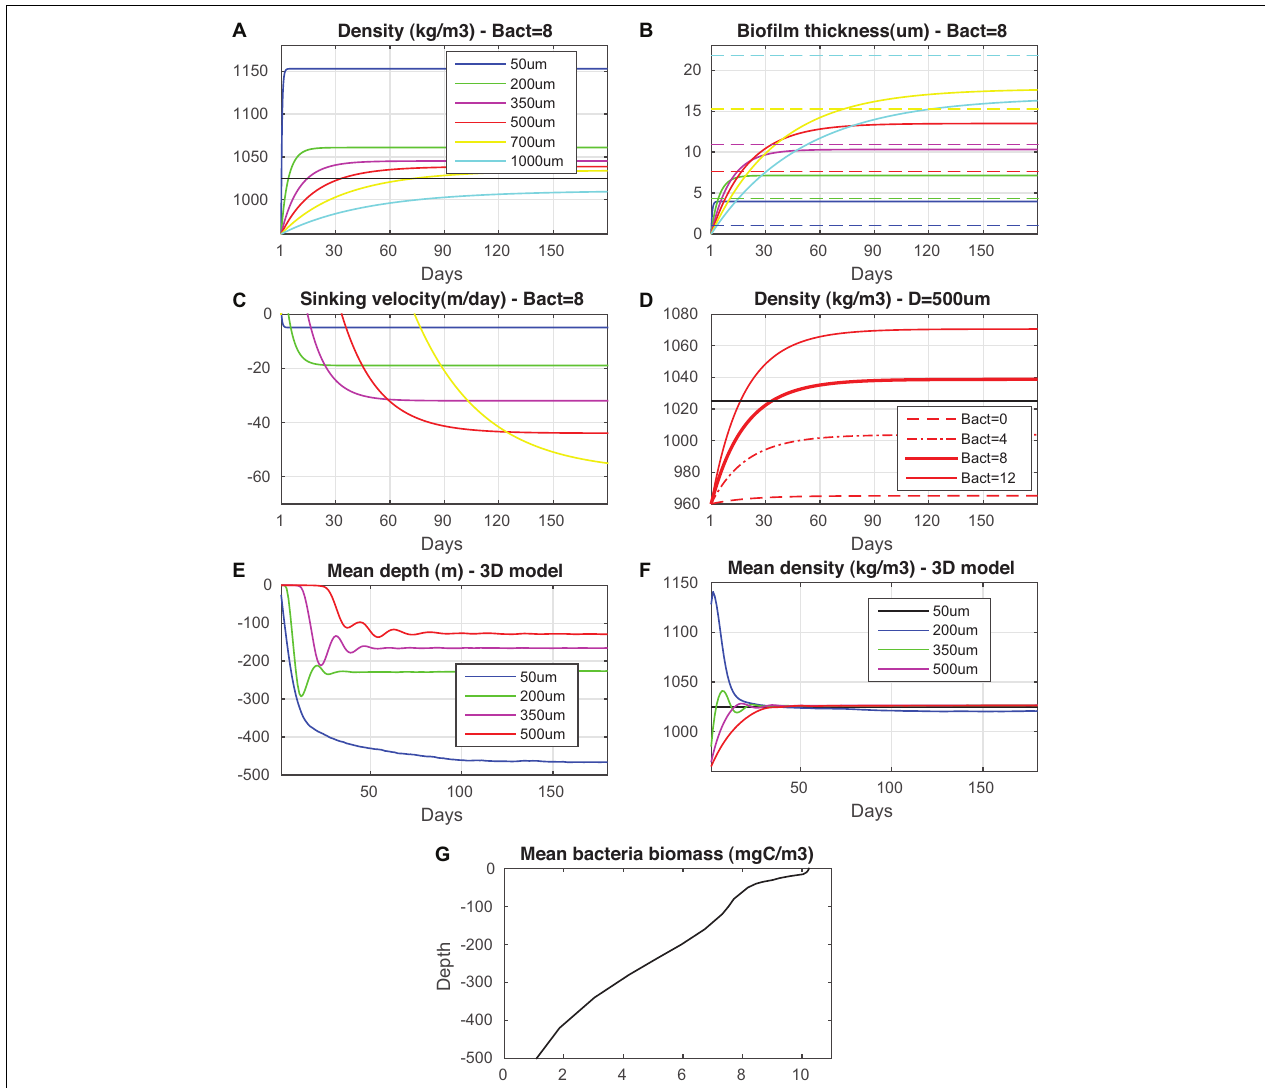
FIGURE 2 | Microplastic particles evolution (in days) of (A) density, (B) biofilm thickness, (C) sinking velocity for different particle size (50, 200, 350, 500, 700, and 1,000 µ m) and constant bacterial abundance (8 mgC/m 3 ) and (D) particle density (size = 500 µ m) for different bacterial abundance (0, 4, 8, and 12 mgC/m 3 ). The critical (dashed colored lines) biofilm thickness for each size class is also indicated in (B) . Microplastics particles (50, 200, 350, and 500 µ m) (E) mean depth (m) and (F) density (kg/m 3 ) evolution in a 3-D model simulation with varying bacterial biomass is shown. The mean Mediterranean bacterial biomass vertical distribution is also shown in (G)